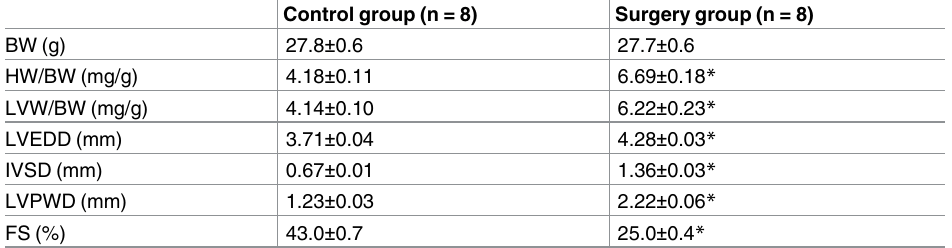
Table 1. Echocardiographic characteristics of the control group and the surgery